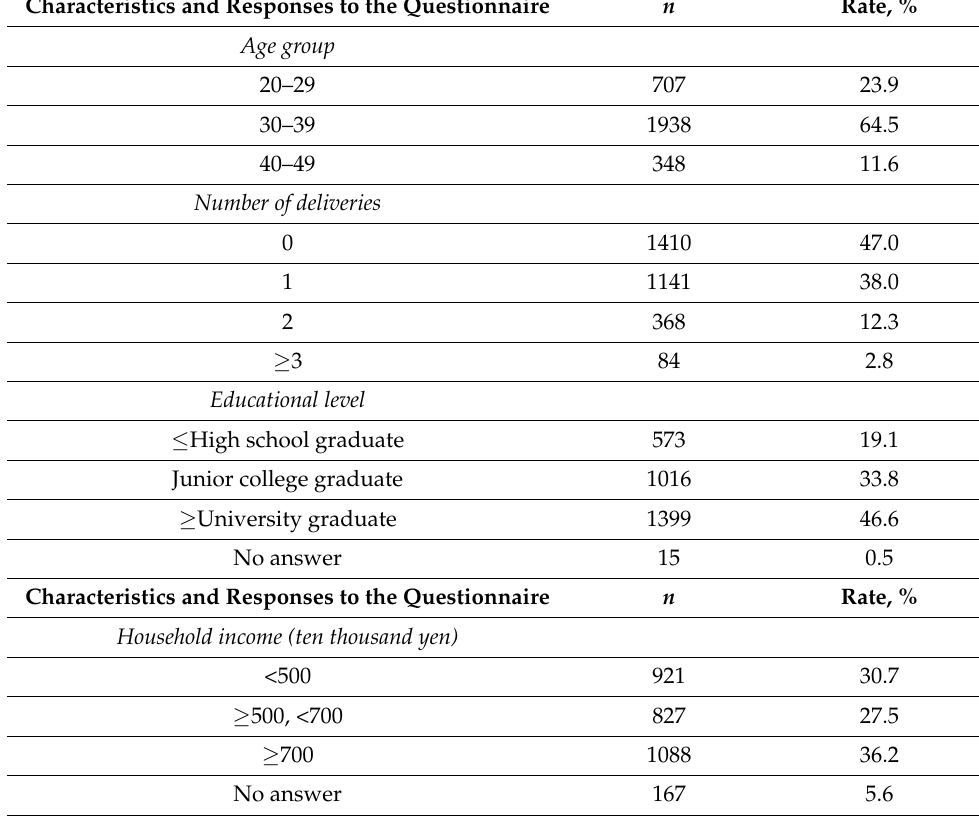
Table 1. Study participants’ characteristics and responses to the questionnaire ( N = 3003). Characteristics and Responses to the